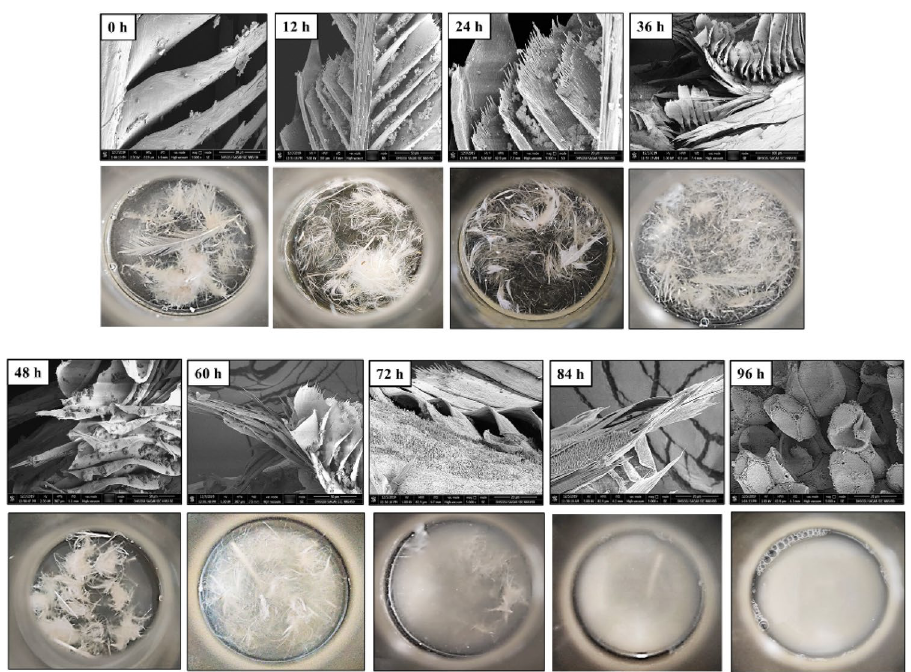
Figure 3. Feather degradation by B. velezensis NCIM 5802. Control (0 h); colonization of bacterial cells on feather surface (12–24 h); initialization of vane degradation (36 h); curling and exposure of secondary fibers (48–60 h); degradation of feather barbs, barbules, and invasion of bacterial cells in the shaft (72–84 h); complete disruption of feather rachis and shaft (96 h) by the colonized bacteria. Feather samples were harvested from the submerged cultures, gold coated and viewed at 5000 X in FEI Scanning electron